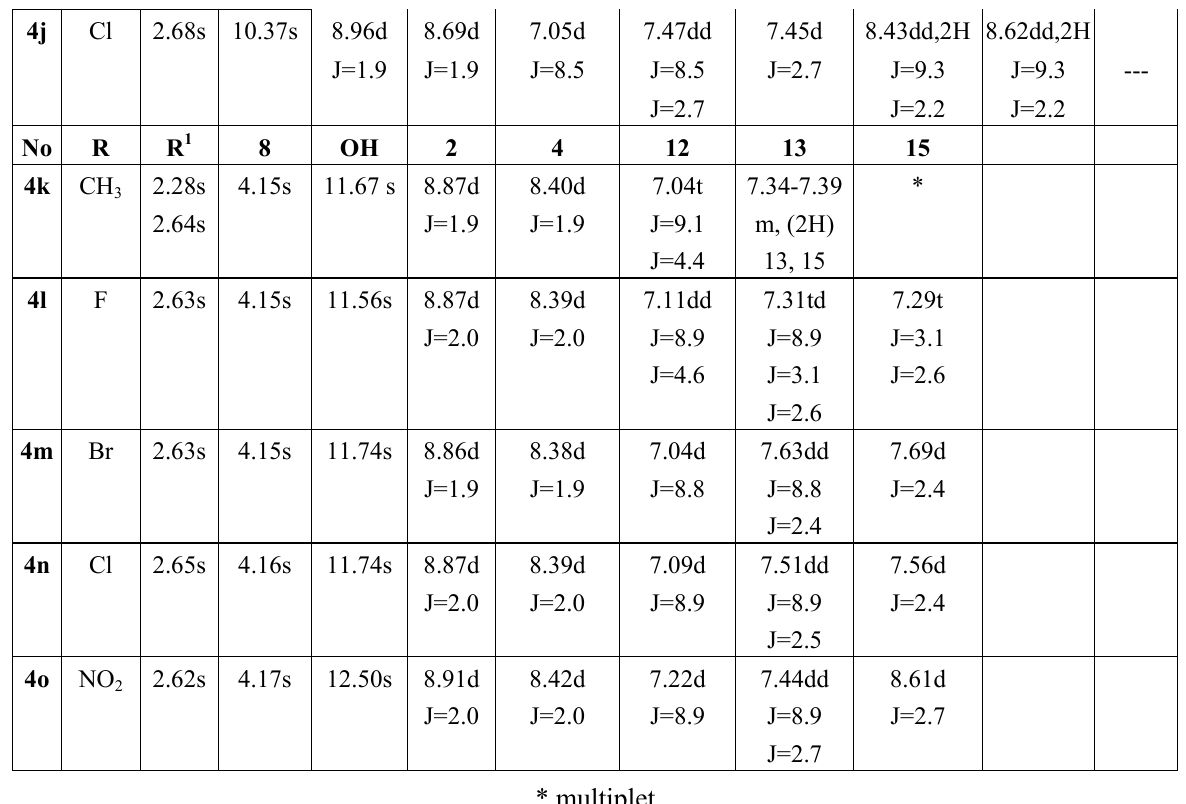
Table 3: 13 C-NMR: δ (ppm), J (Hz )(CDCl